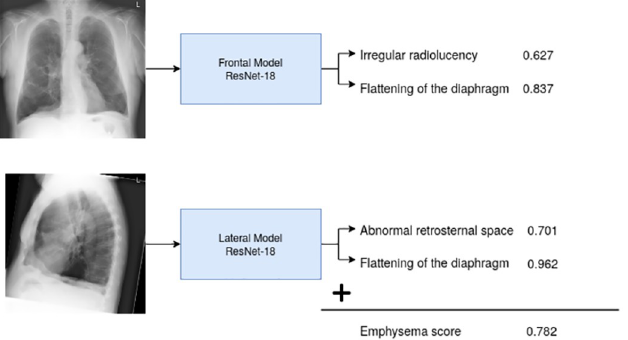
emphysema score. The indicated scores are calculated using the CXRs shown in the figure for this specific